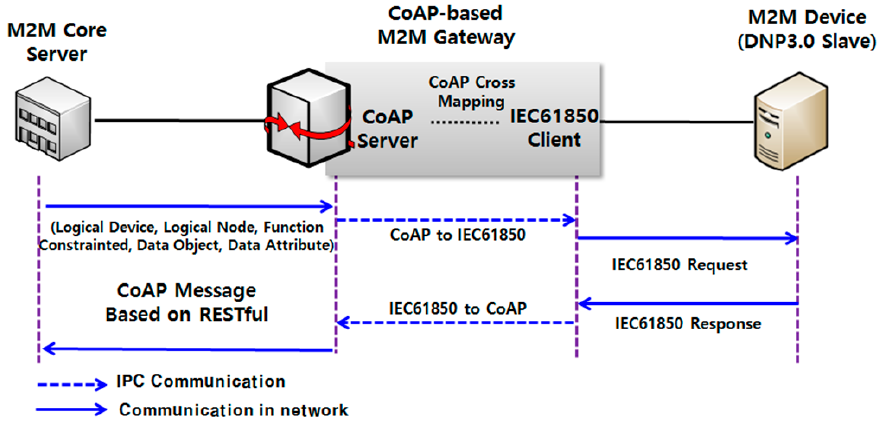
Figure 4. Protocol flow between a M2M core server and M2M device using the IEC 61850 in a M2M environment.